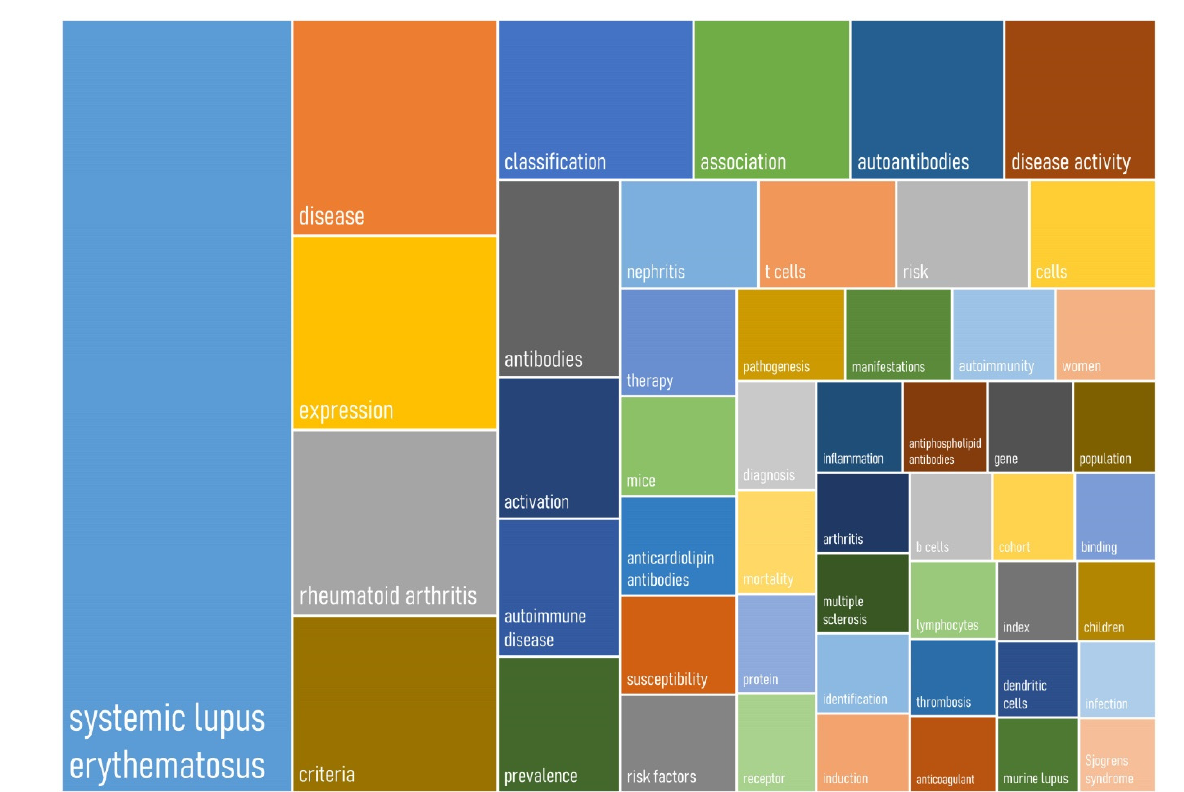
Figure 4. A treemap chart of the 50 most frequently occurring “KeyWords Plus” terms in original articles on systemic lupus erythematosus from 1971 to 2020.